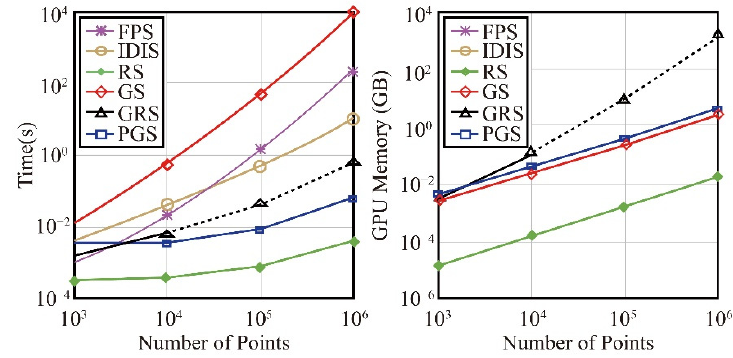
Figure 10. Efficiency comparison of different sampling methods.